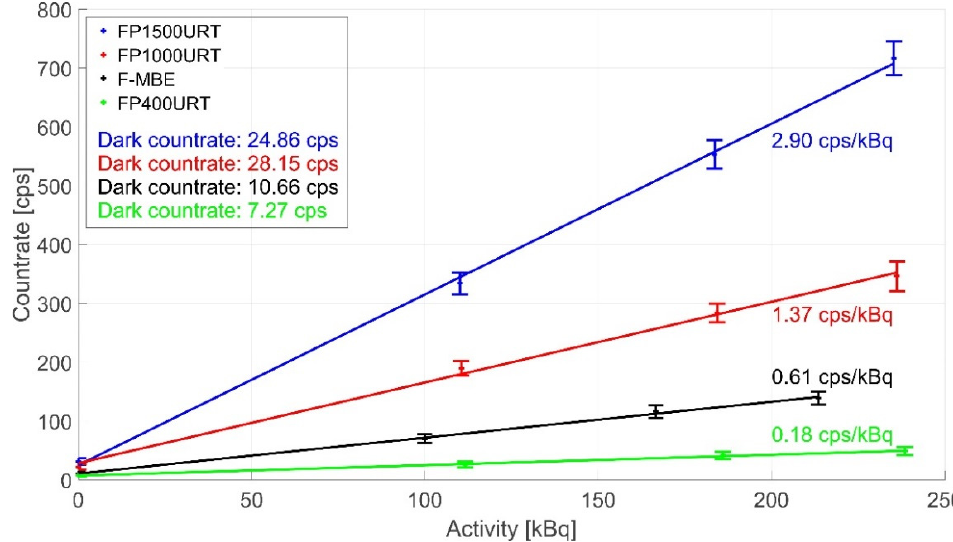
Figure 7. Dosimeter measurement sensitivity comparison using the LYSO(Ce) crystal and different optical fibre links of 1 m length under irradiation of ID1–ID3 sources.